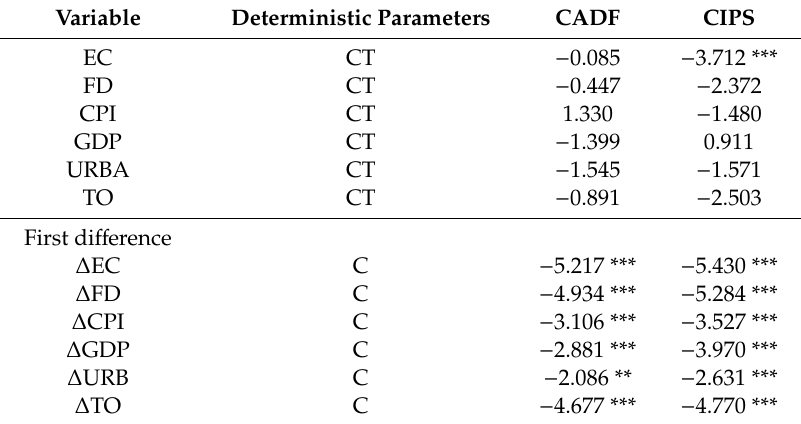
Table 2. Cross-sectional Augmented Dickey Fuller (CADF) and Cross-sectional Im, Pesaran, and Shin (CIPS) panel unit root test [30].